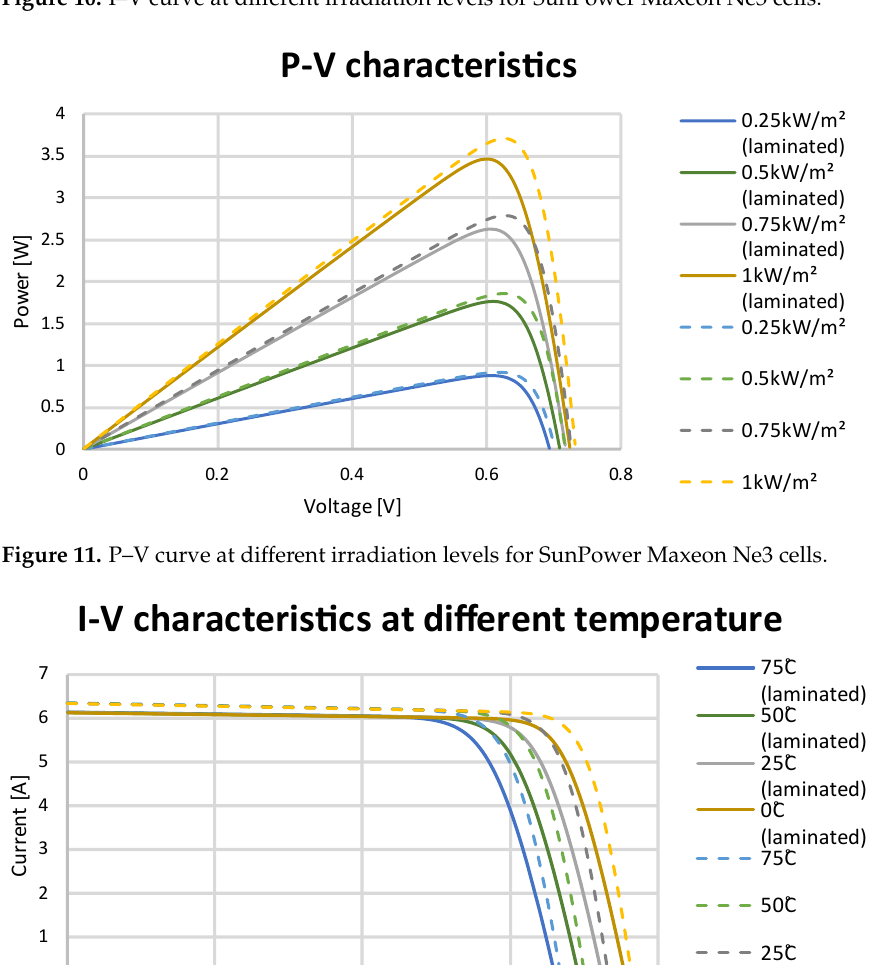
Figure 11. P – V curve at different irradiation levels for SunPower Maxeon Ne3 cells. Table 5. MPPT data of tested solar cell.